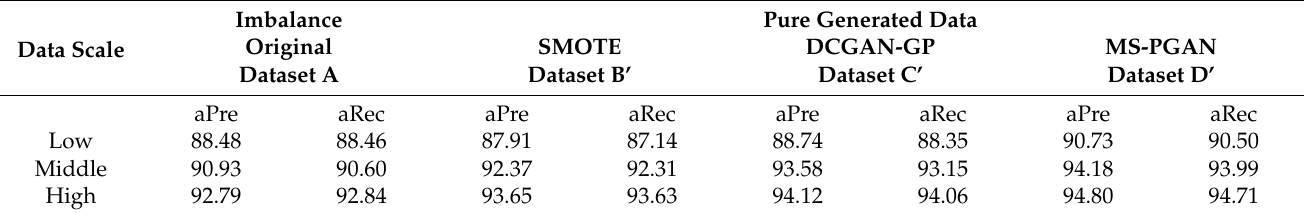
Table 7. The average precision and recall (%) of the imbalanced and pure generated datasets by